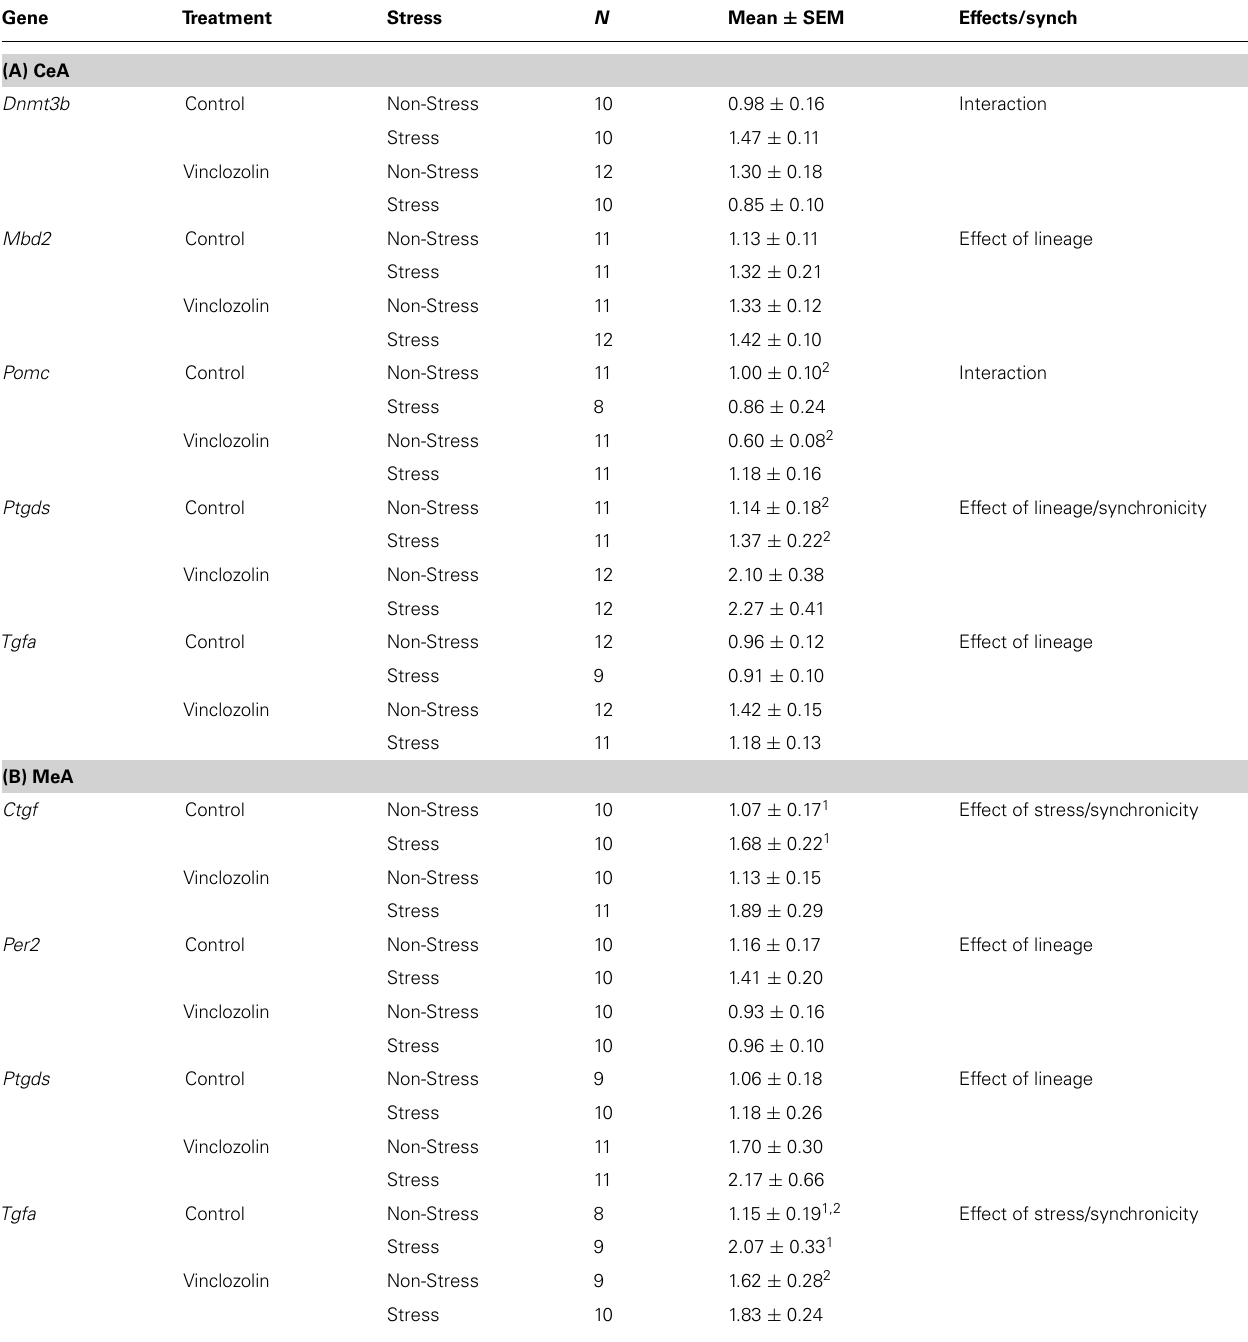
Table 2 |Amygdala data